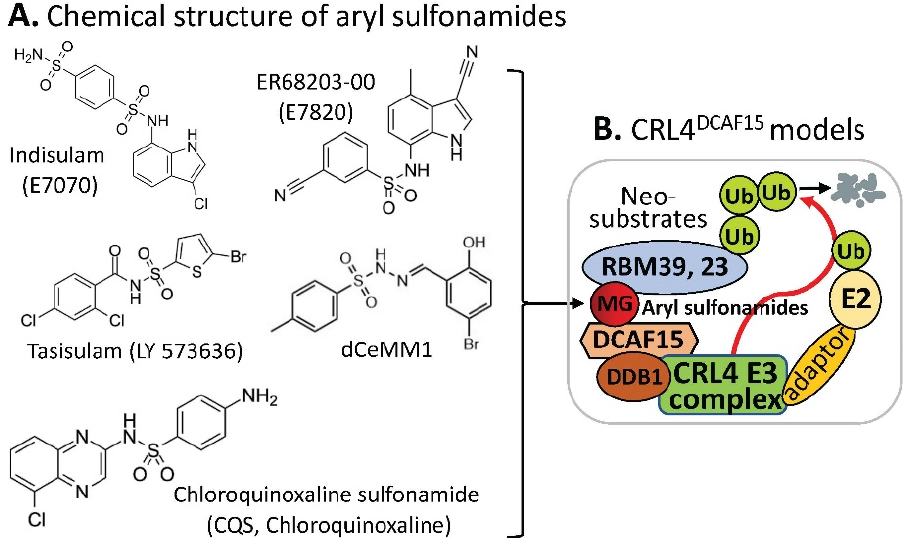
* Table 2 data summary is based on the review article written recently by Kozicka and Thoma [12]. # Abbreviations: RBM39 , RNA-binding motif protein 39.